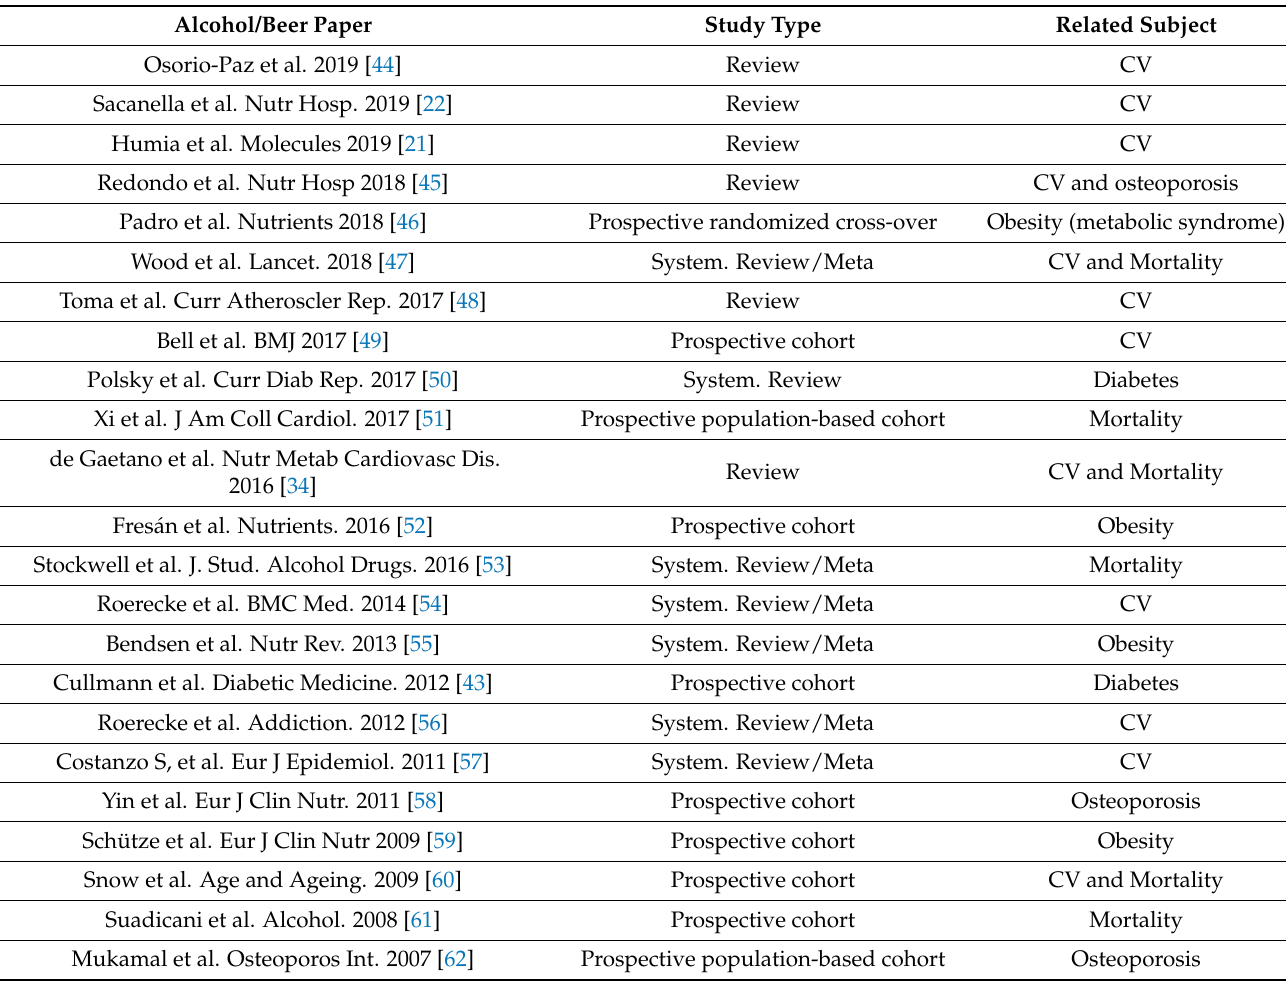
Table 3. Papers selected for